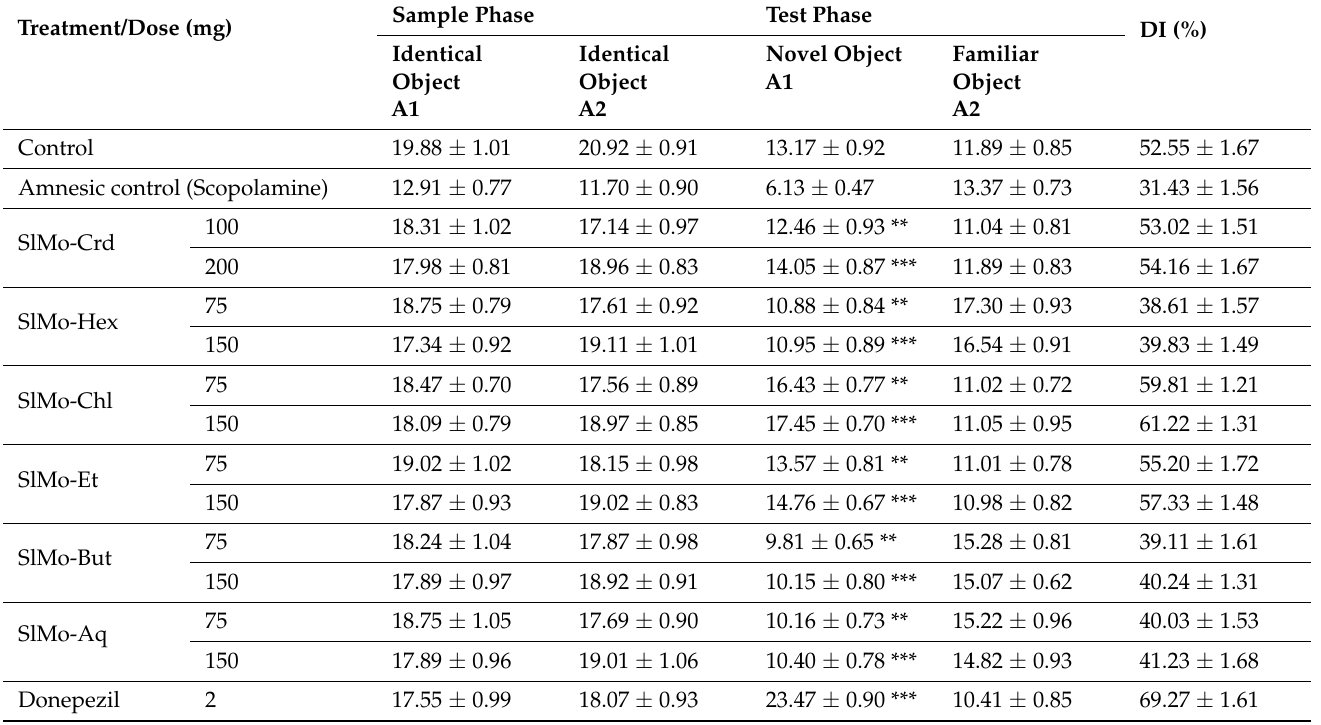
Table 3. Effects of crude extract and various fractions of S. moorcroftiana on mice in behavioral NORT on long-term